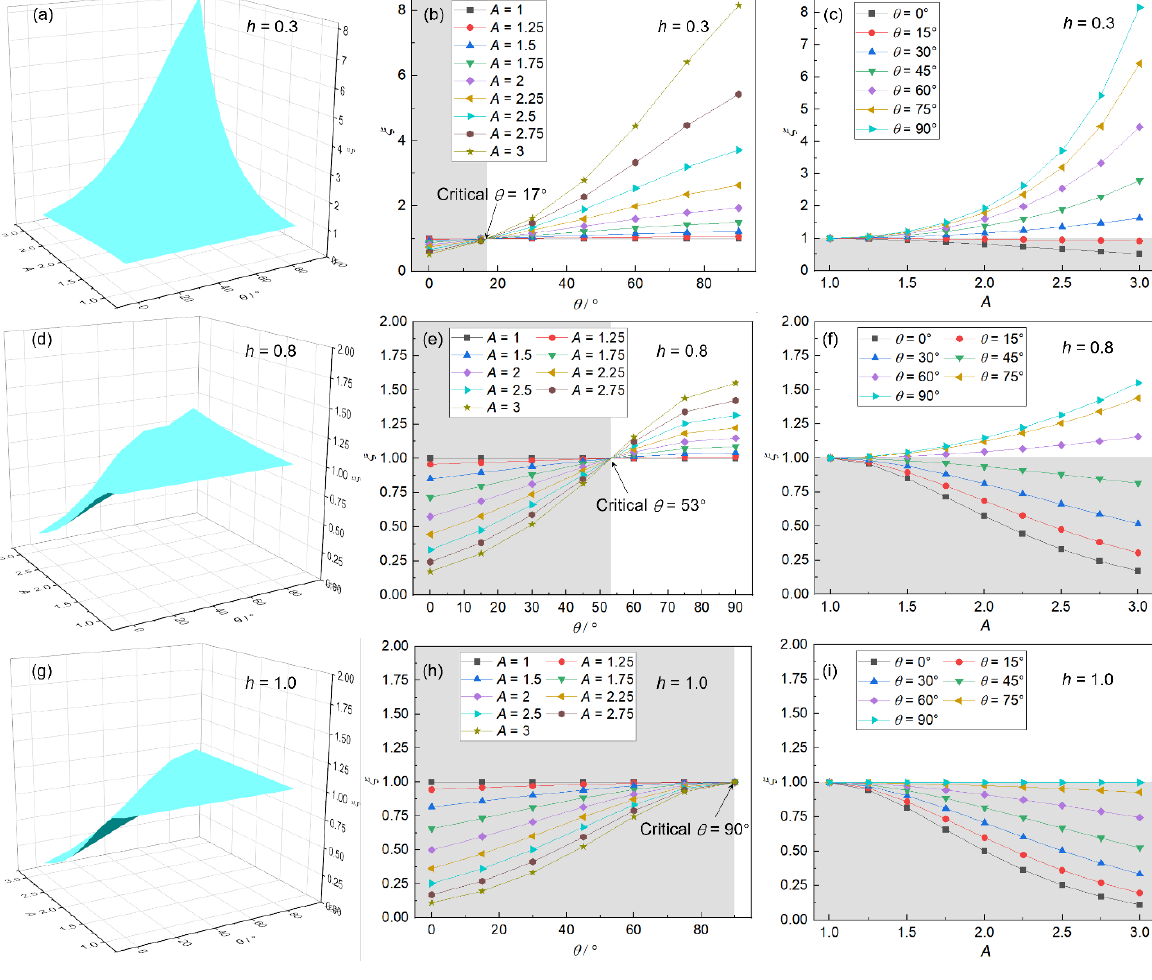
Figure 12. The effect of aspect ratio, A , and tilting angle θ , on inclusion shape parameter, ξ : ( a – c ) h = 0.3; ( d – f ) h = 0.8; ( g – i ) h = 1.0 (the grey parts represent that the value of ξ decreases when A in- creases).